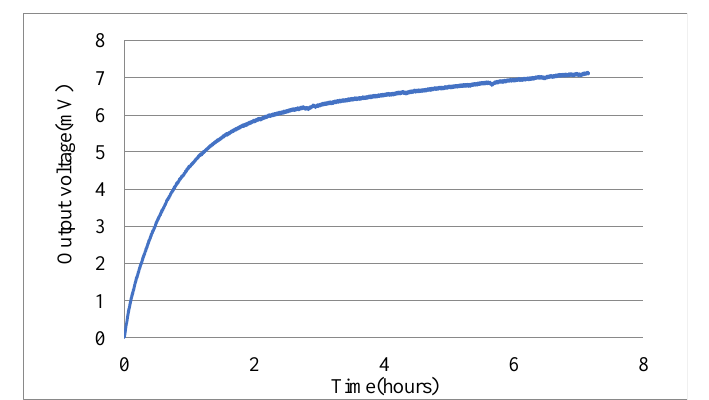
Figure 3. Turning-on drift of one accelerometer.